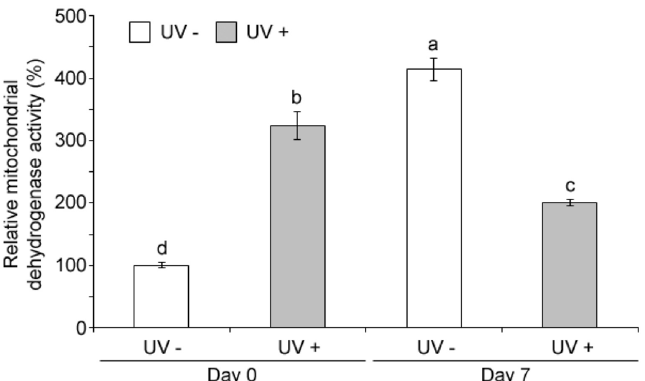
Figure 6. Effect of UVC on mitochondrial dehydrogenase activity. Acerola fruits, without (UV−) or with the UVC treatment (UV+) were stored at 10 °C for 0 day (Day 0) or 7 days (Day 7) and subjected to the MTS assay. Data, obtained from at least three biological repeats, are shown as mean ± SE values. Different letters indicate significant differences by the ANOVA/Tukey-HSD ( p <